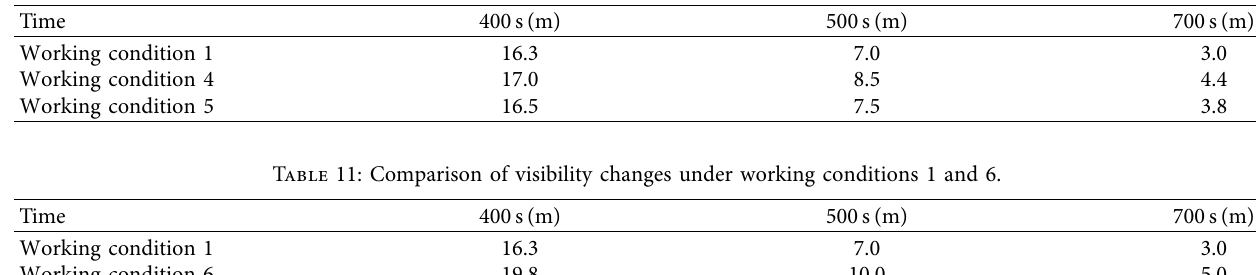
Table 10: Comparison of visibility changes under working conditions 1, 4, and 5.